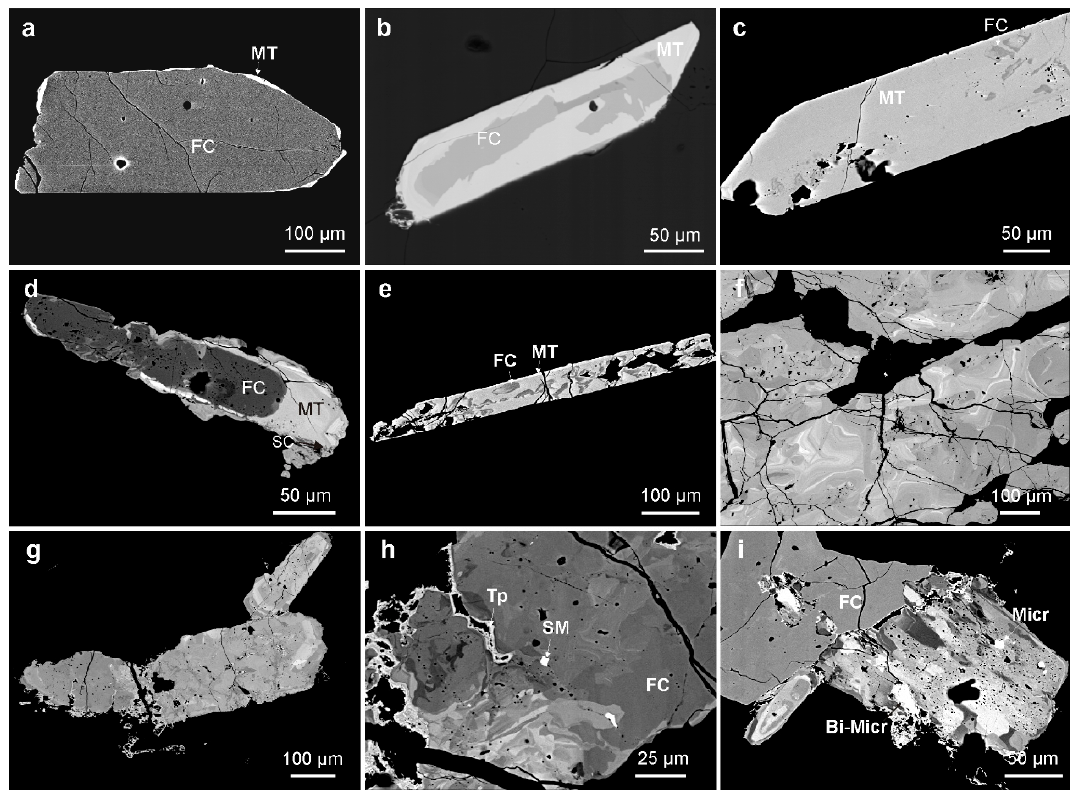
Figure 12. Textural patterns of Nb-Ta minerals from type-IV pegmatites, SEM images, mode BSE, ( a ) columbite-(Fe) crystal (FC) with a narrow tantalite-(Mn) rim (MT). ( b ) columbite-(Fe) crystal (FC) replaced by tantalite-(Mn) (MT), ( c ) tantalite-(Mn) crystal (MT) with minor columbite-(Fe) (FC) relict areas. ( d ) columbite-(Fe) (FC) partly rimmed by tantalite-(Mn) (MT) with a small grain of stibiocolumbite (SC), ( e ) columbite-(Fe) crystals with convoluted complex zoning, ( f ) detail of the above columbite crystal with convoluted zoning, with bands richer in Ta (lighter) and in Nb (darker). ( g ) columbite crystals with patchy complex zoning and replacements, ( h ) detail of image g, where replacements of patchy zoned columbite-(Fe) (FC) by stibiomicrolite (SM) and tapiolite (TP) in veinlets are more visible, ( i ) columbite-(Fe) crystal (FC) replaced by microlite (Micr) and Bi-rich microlite (Bi-Micr).